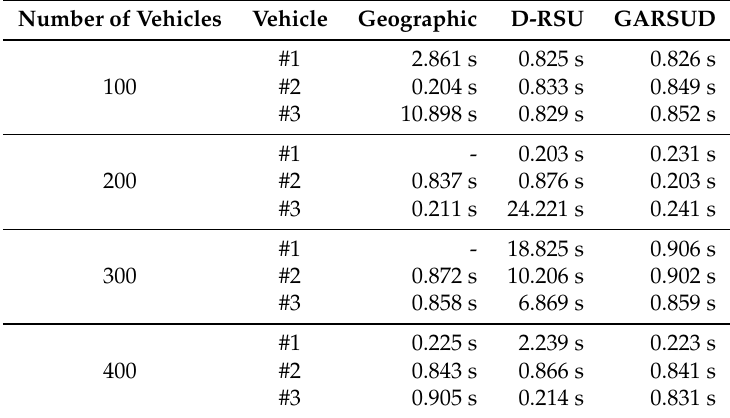
Table 4. Warning notification time (in seconds) for each warning vehicle when deploying 9 RSUs in Valencia considering a uniform traffic